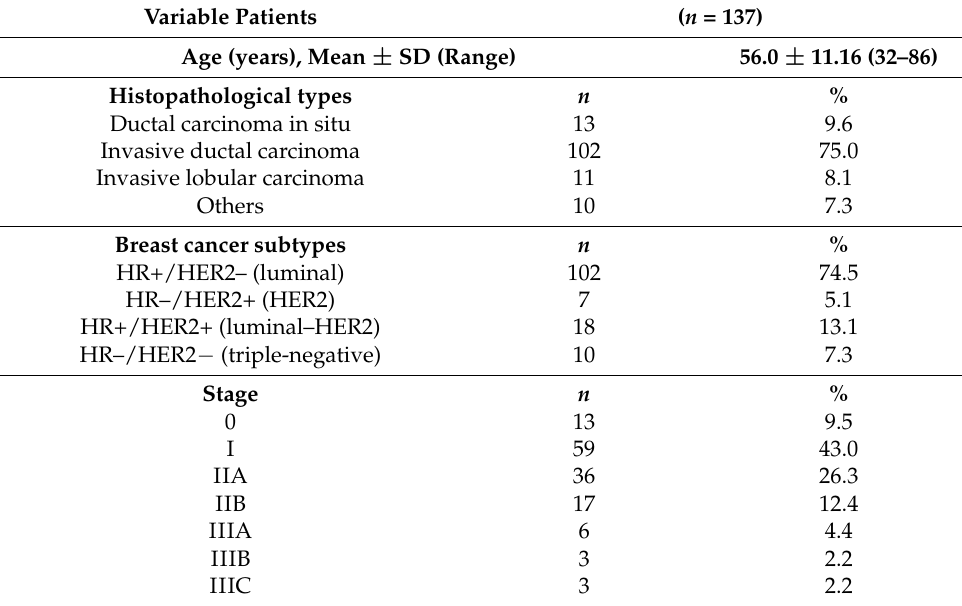
Table 1. Clinical characteristics in patients with primary breast cancer.